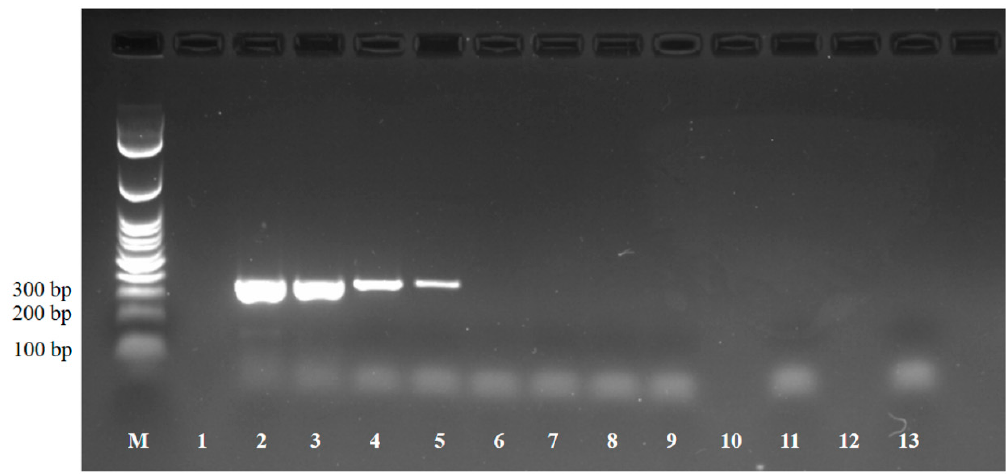
Figure 2. Sensitivity of SAG1 RT-PCR technique for detection of T. gondii tachyzoites RH strain. M marker in 100 bp ladder, Lane 1 empty space, Lane 2 RNA extracted by 10 4 tachyzoites, Lane 3 RNA extracted by 10 3 tachyzoites, Lane 4 RNA extracted by 10 2 tachyzoites, Lane 5 RNA extracted by 10 tachyzoites, Lane 6 RNA extracted by 1 tachyzoite, Lane 7 RNA extracted by 10 − 1 tachyzoites, Lane 8 RNA extracted by 10 − 2 tachyzoites, Lane 9 RNA extracted by 10 − 3 tachyzoites, Lane 10 empty space, Lane 11 negative control, Lane 12 empty space, Lane 13 RNA extracted by tachyzoites inactivated by heating.